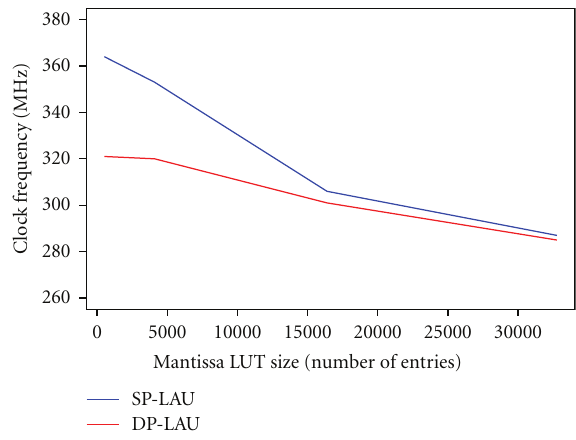
Figure 6: LAU frequencies with respect to LUT